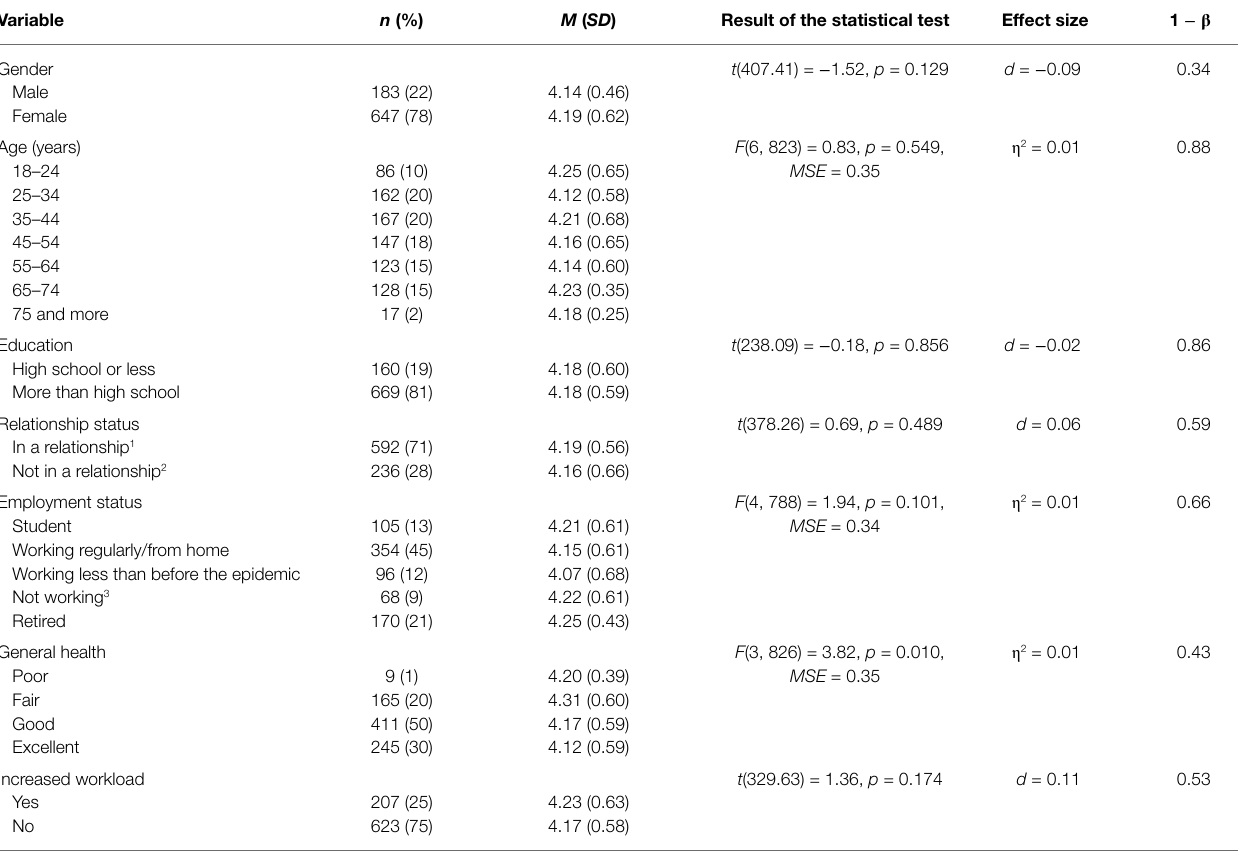
TABLE 1 | Description of nominal variables and comparison of subgroups on the Cognitive Change Questionnaire (CCQ) score. Variable n (%) M ( SD ) Result of the statistical